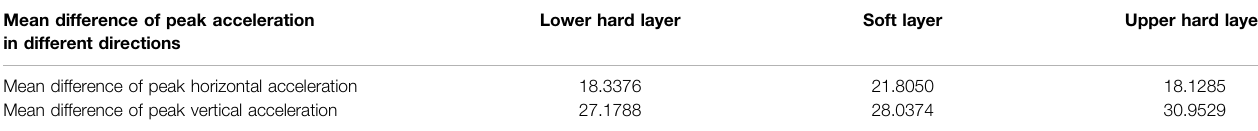
TABLE 6 | Mean differences of the peak horizontal and vertical acceleration of each layer in different blast directions. Mean difference of peak acceleration in different